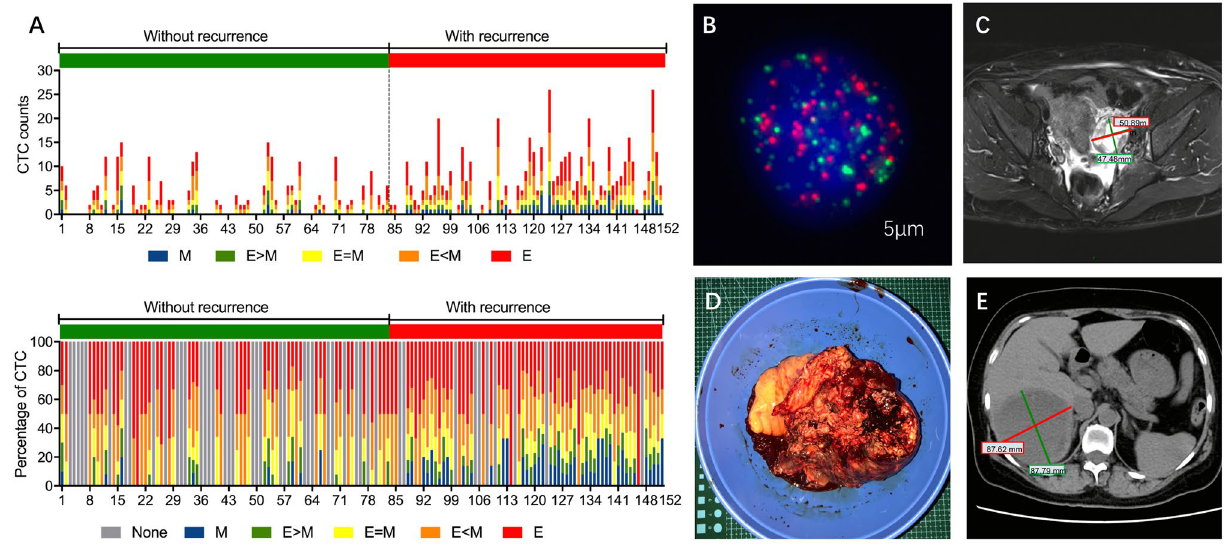
Figure 1. ( A ) Total CTC counts (top) and percentage of each CTC category (bottom) before treatment in ovarian cancer patients with or without recurrence. ( B ) The CTC image and ( C ) Magnetic Resonance Imaging (MRI) image of a representative patient who had the CTC-positive blood sample before treatment. ( D ) After tumor resection, the patient suffered cancer recurrence with ( E ) detectable liver metastasis observed by Magnetic Resonance Imaging (MRI) at 6-month